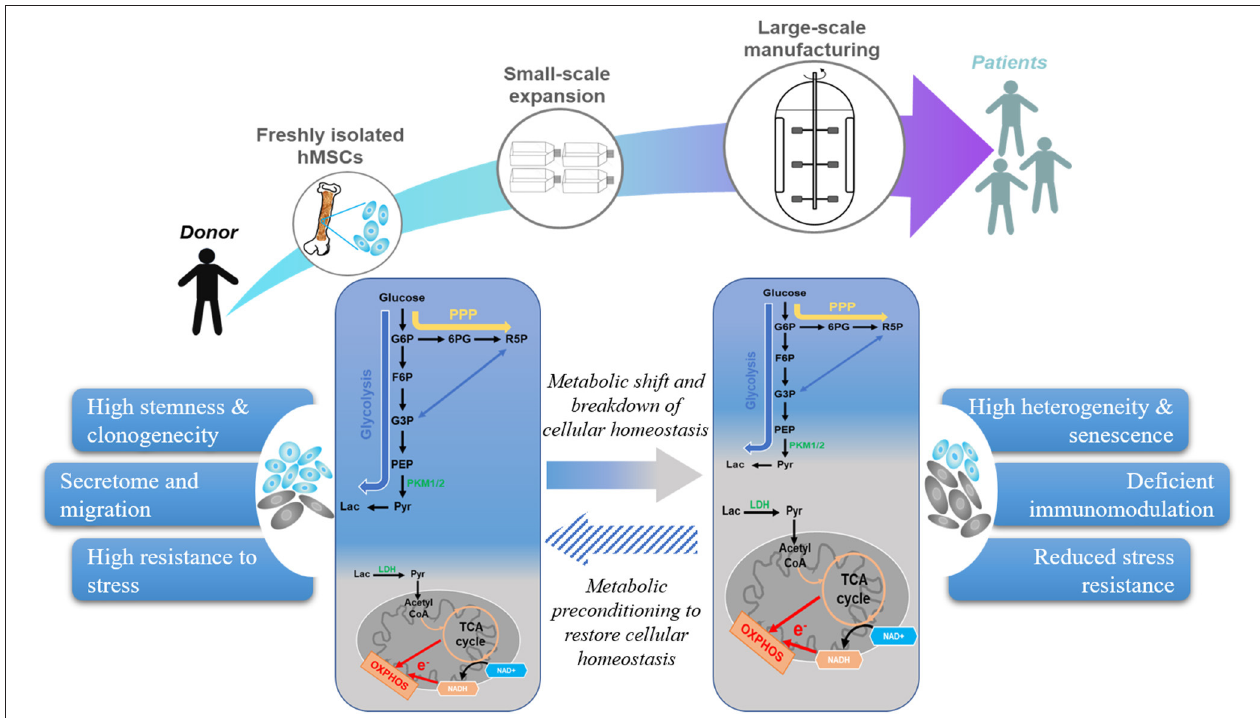
FIGURE 1 | Current hMSC manufacturing practices lead to metabolic shift that reduces therapeutic properties. hMSC manufacturing utilizes freshly isolated hMSCs and expand under artificial environment to obtain sufficient cell number for clinical application. However, external stresses during replicative expansion, and cryopreservation shift hMSC metabolism from glycolysis toward OXPHOS, which increases senescent subset and contributes to a breakdown of cellular homeostasis. Metabolic preconditioning targeting specific pathways can restore hMSC cellular homeostasis and enhance their therapeutic